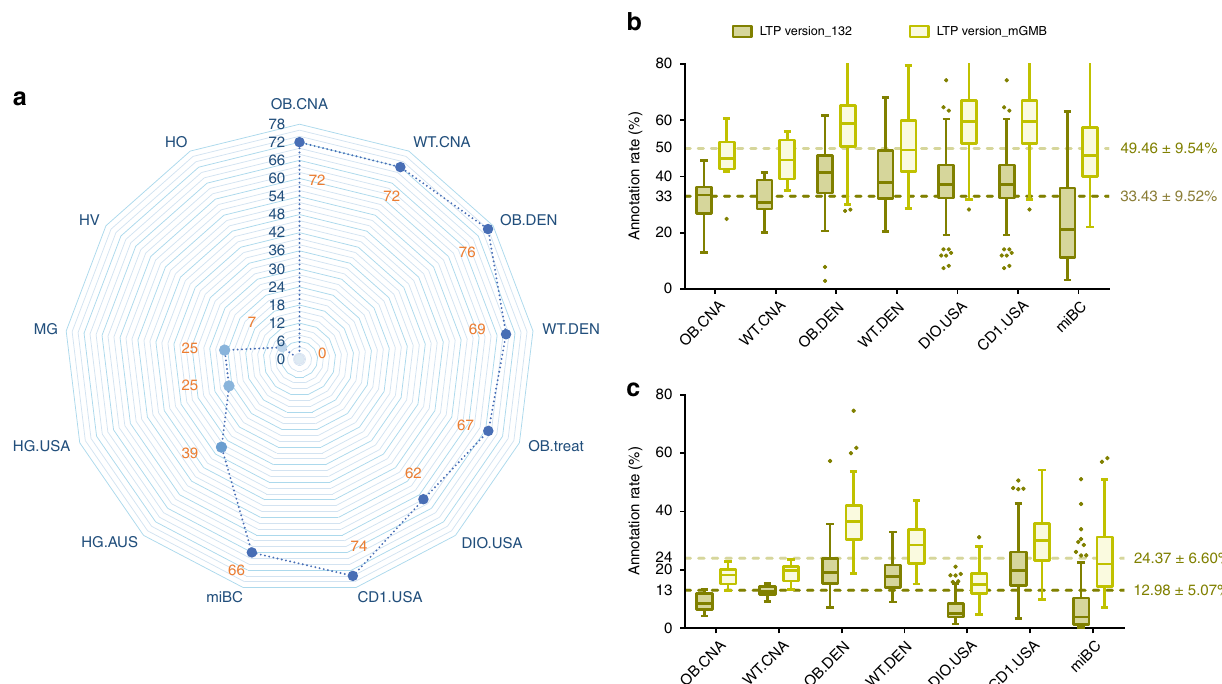
Fig. 2 The 16S rRNA gene amplicon-based analysis of the prevalence of novel species in the mGMB. a Radar plot depicting the prevalence of 77 novel taxa within the host-associated microbiotas from diverse hosts. The numbers of novel species that got hits on OTUs in datasets were marked in orange. OB.CNA: the gut microbiota of ob/ob mice from China ( n = 12), WT.CNA: the gut microbiota of C57BL/6J mice from China ( n = 12), OB.DEN: the gut microbiota of ob/ob mice from Denmark ( n = 239), WT.DEN: the gut microbiota of C57BL/6J mice from Denmark ( n = 120), OB.tre = t: the gut microbiota of ob/ob mice from China treated with anti-metabolic-syndrome medicine SA-7 ( n = 31), DIO.USA: the gut microbiota of diet-induced obese mice from the USA ( n = 25), CD1.USA: the gut microbiota of outbred CD1 mice from the USA ( n = 208), miBC: the gut microbiota of mice with different genetic backgrounds and housed in various facilities in Europe and America from miBC ( n = 93), HG.AUS: the gut microbiota of humans from Australia ( n = 300), HG.USA: the gut microbiota of humans from USA ( n = 97), MG: the gut microbiota of rhesus monkeys from China ( n = 160), HV: the microbiota of the human vagina ( n = 20), HO: the microbiota of the human oral cavity ( n = 66). b , c The novel taxa improved the annotation rate of the 16S rRNA gene amplicon data of murine GMs at the genus level ( b ) and at the species level ( c ). LTP version_132 (olive drab): data annotated using LTP database version 132, LTP version_mGMB (light yellow): data annotated using a customized LTP database by supplementing the 16S rRNA gene sequences of 77 novel species; data are shown in box-and-whiskers plot, center line: median, bounds of box: quartile, whiskers: Tukey extreme; the mean ± SEM of annotation rates using different databases were given in the panels and were statistically determined to be signi fi cantly different ( p < 0.001) by t test. The n numbers represent the biologically independent samples. Source data are provided as a Source Data fi